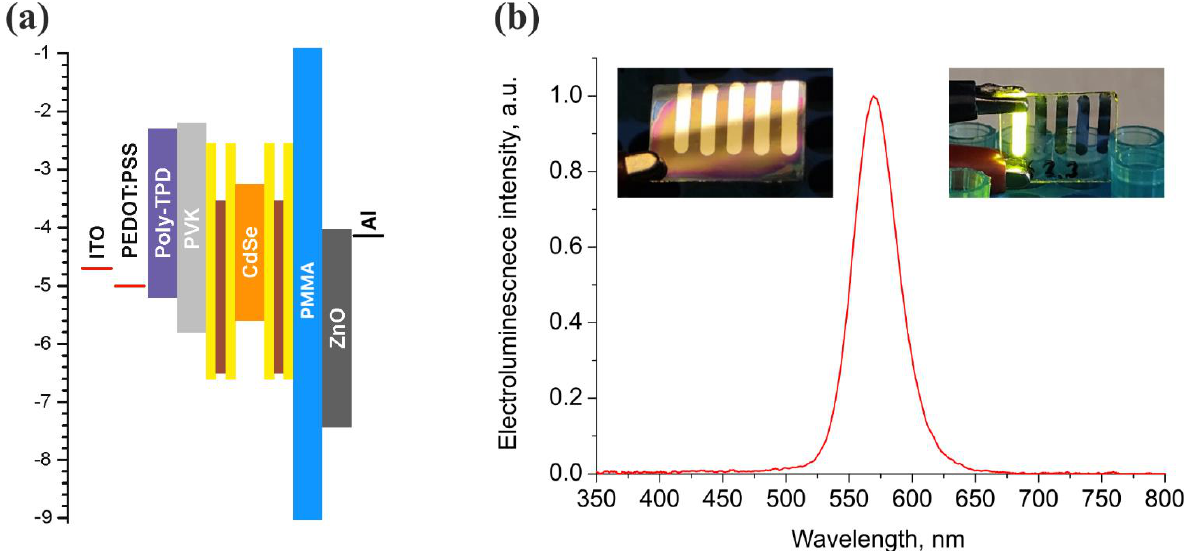
Figure 1. Flat-band energy level diagram of the fabricated QDLEDs ( a ) and electroluminescence spectrum of QDLED with the PMMA electron-blocking layer deposited from a solution with a PMMA concentration of 0.2 mg/mL ( b ). The insets in panel ( b ) show photographs of the device under ambient light (left) and operated at 6 V (right).